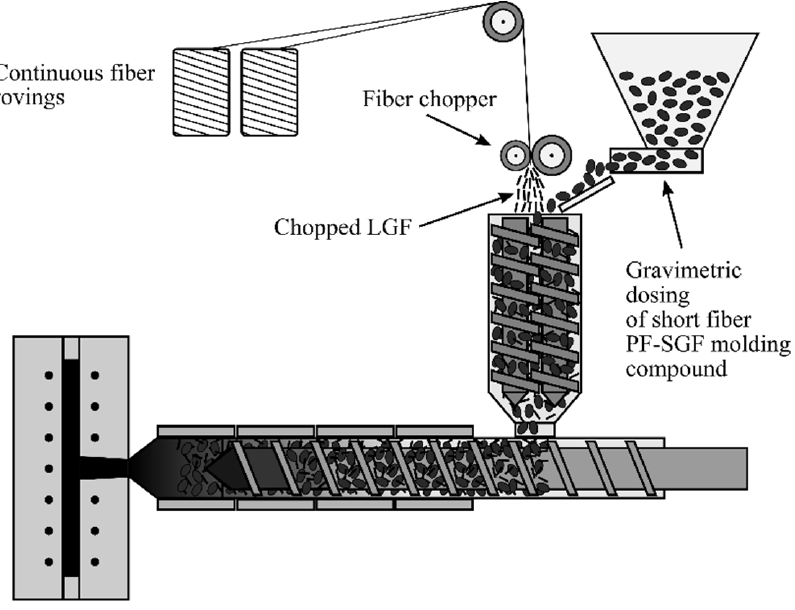
Figure 1. Process scheme of the long fiber injection molding process.